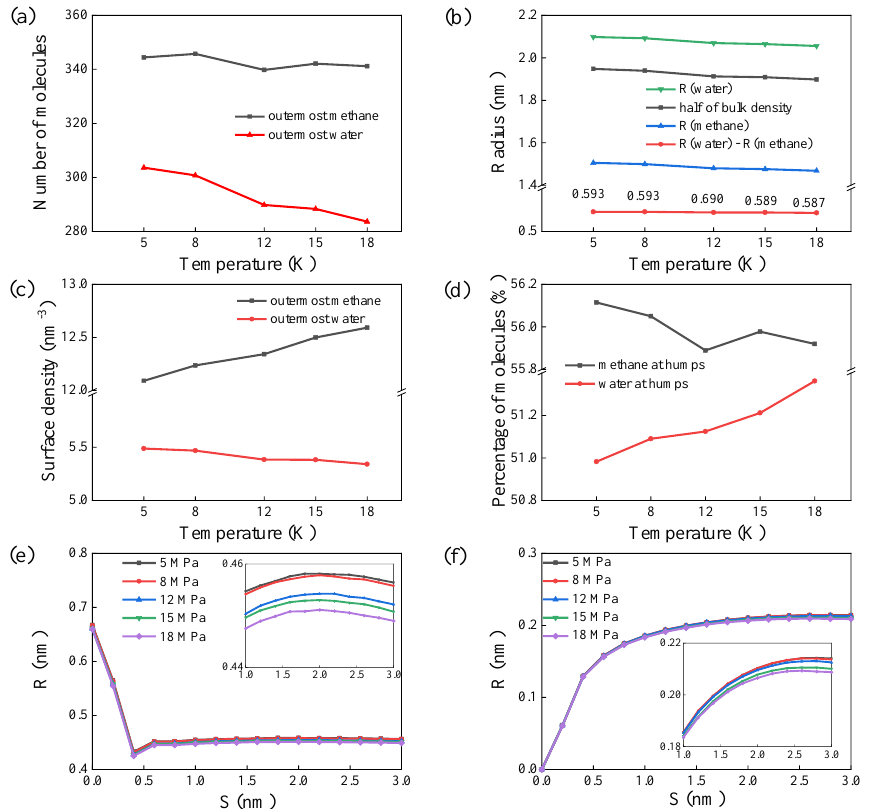
Figure 7. Time averages of ( a ) the total numbers of the outermost methane and water molecules, ( b ) bubble radii, ( c ) the surface densities of the outermost methane and water molecules, ( d ) the percentages of methane and water molecules at humps, and R as a function of S for ( e ) the outermost methane molecules and ( f ) the outermost water molecules in Sys4 at 313.15 K and different pressures.